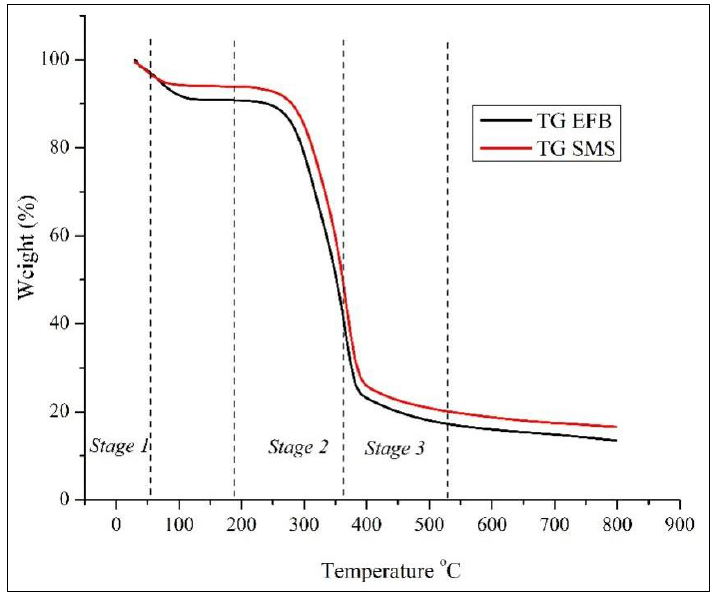
Figure 6. Thermal degradation trends of the TG profile of the SMS and FRS fibers in three stages. Table 1. Thermal degradation analysis of the SMS and EFB